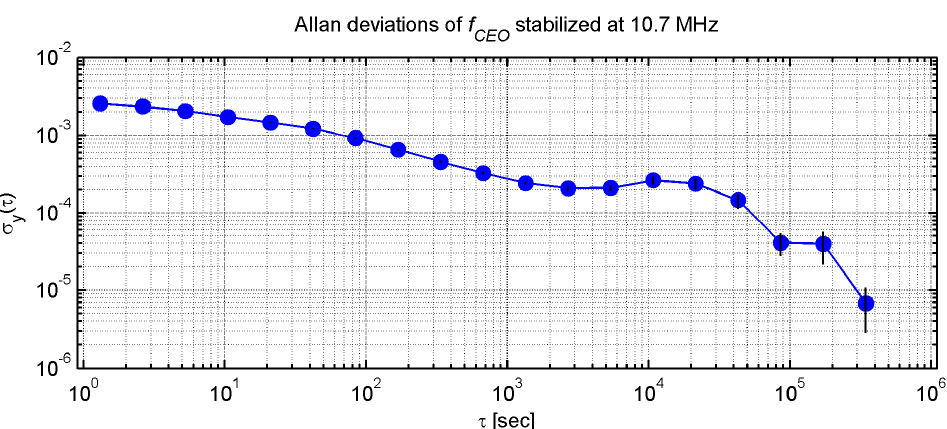
Figure 7. Allan deviations of the offset frequency of the comb stabilized at 10.7 MHz by software-defined radio based PLL and FLL measured for approximately eight